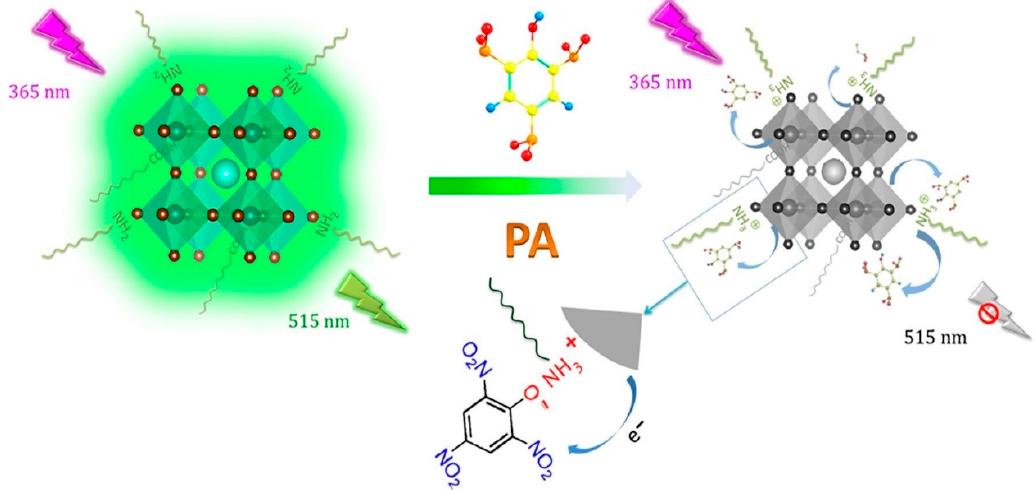
Figure 12. Schematic illustration for the sensitive fluorescence detection of picric acid (PA) -based on perovskite quantum dots (reproduced with the permission from reference [142]).